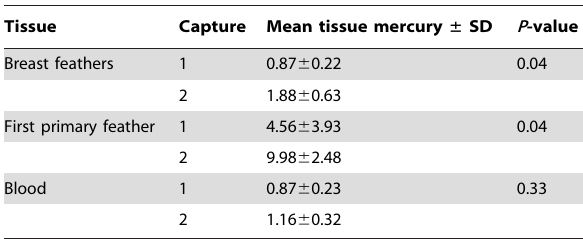
Table 3. Mean tissue mercury concentrations (ppm fw (feathers) or ww (blood)) for six Nelson’s Sparrows banded and recaptured at GFND (Fig. 1) in two different breeding